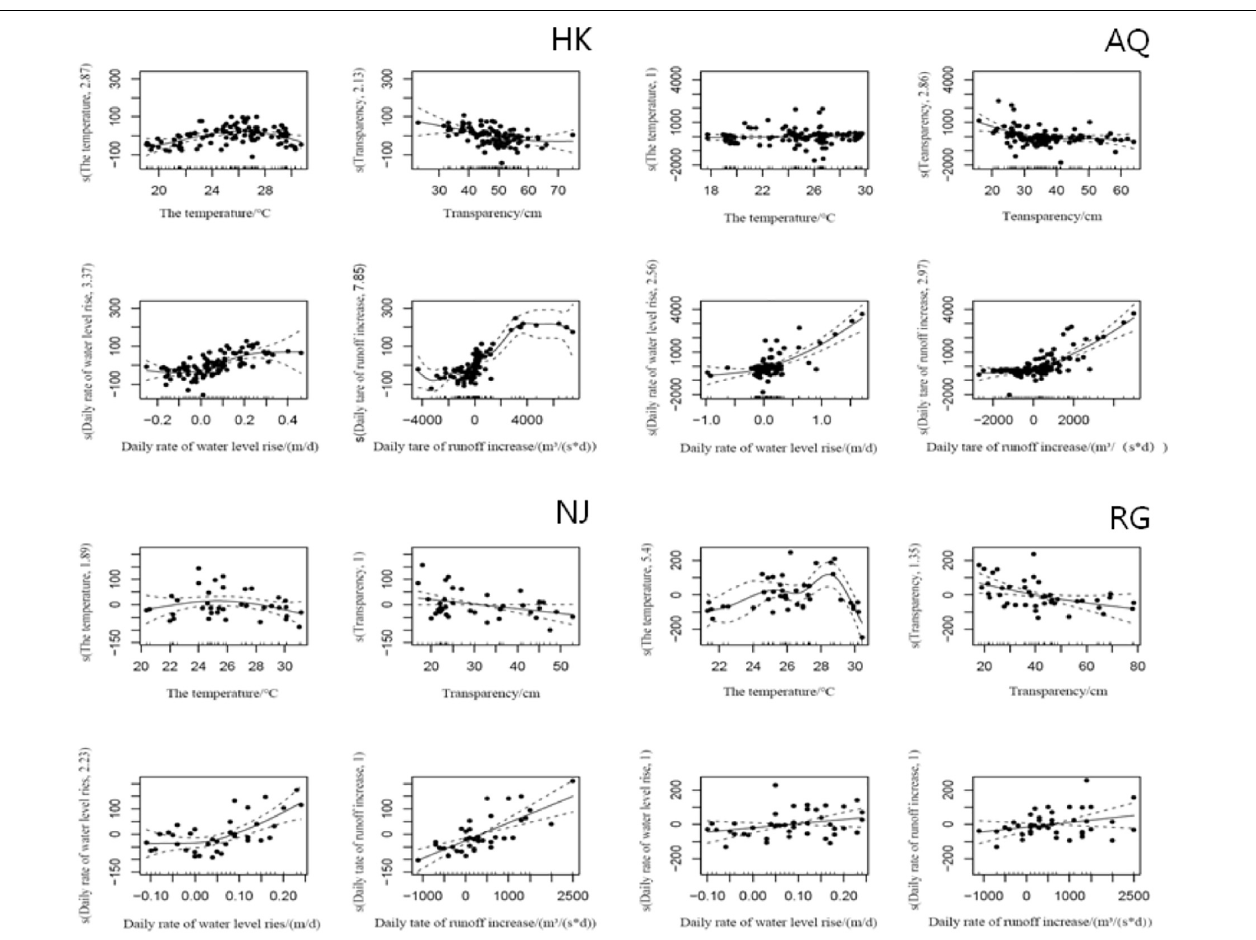
FIGURE 6 | Generalized additive model analyses for ichthyoplankton in the sampled section. The ordinate s() is the nonparametric smoothing term, and the abscissa is the parameter value. The solid line represents the regression curve obtained by automatically determining the smoothing parameters, and the dotted line represents the possible variation range of the regression